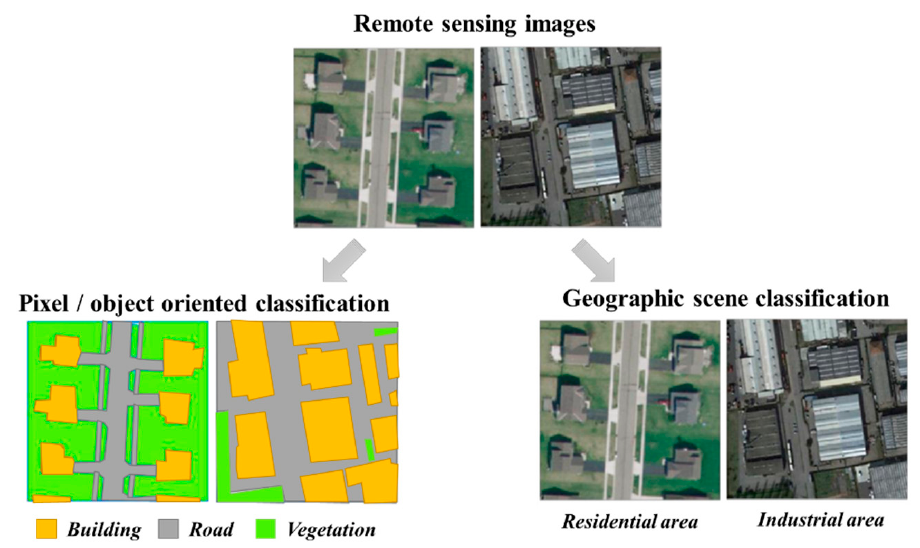
Figure 3. Understanding differences of geographic scenes at different semantic layers. (3) The data characteristics of HSR remote sensing images have both opportunities and challenges for the geographic scene understanding. The amount of HSR remote sensing images increases significantly. As the spatial resolution increases, the area of the ground covered by each pixel decreases significantly. This makes the ground object details and spatial distribution of HSR remote sensing images clearer. Compared with medium–low- resolution remote sensing images, HSR remote sensing images can be interpreted at the scene level, where semantic information is more abstract. However, compared with natural images, the HSR remote sensing images used for geographic scene understanding are less accessible in terms of data availability, except for the differences in shooting distance, shooting angle and imaging sensors. Natural images can be easily and quickly obtained from the Internet, and a large amount of data has been given the relevant label information when uploaded to the Internet [20]. For example, the ImageNet dataset [21,22] contains more than 14 million labeled samples in 1000 categories. HSR remote sensing images are not freely available for political, military and security reasons. HSR remote sensing images often rely on professional interpretation or even field research to obtain the correct label, the available sample size is limited. For instance, the UC-Merced dataset contains only 21 categories, with a total of 2100 labeled samples. Currently, the HSR remote sensing image datasets commonly used for geographic scene understanding are shown in Table